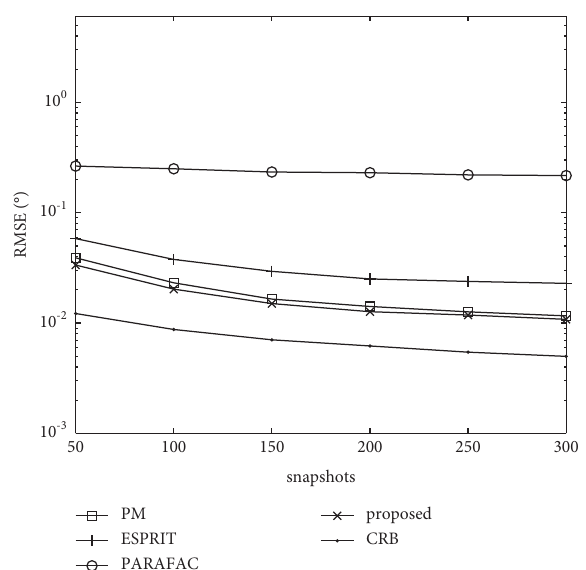
Figure 9: DOA estimation of different algorithms versus